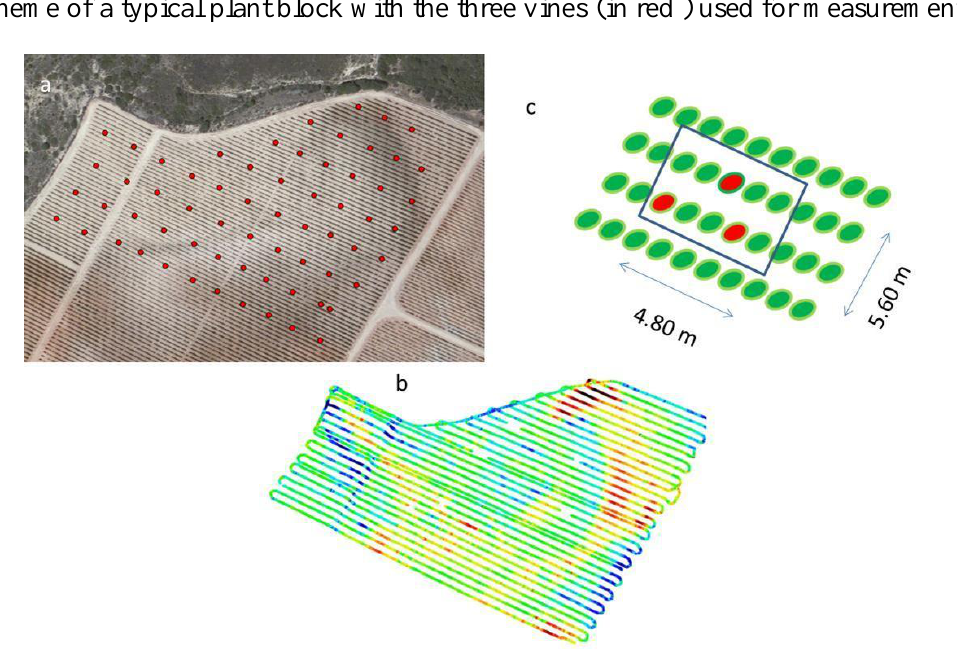
Figure 2. Field measurement locations ( a ) aerial photograph of the field with the position of plant measurement sites (red dots: center of each plant measurement block). ( b ) electrical resistivity transects with average ER values for layer 1 (0–50 cm depth). ( c ) scheme of a typical plant block with the three vines (in red ) used for